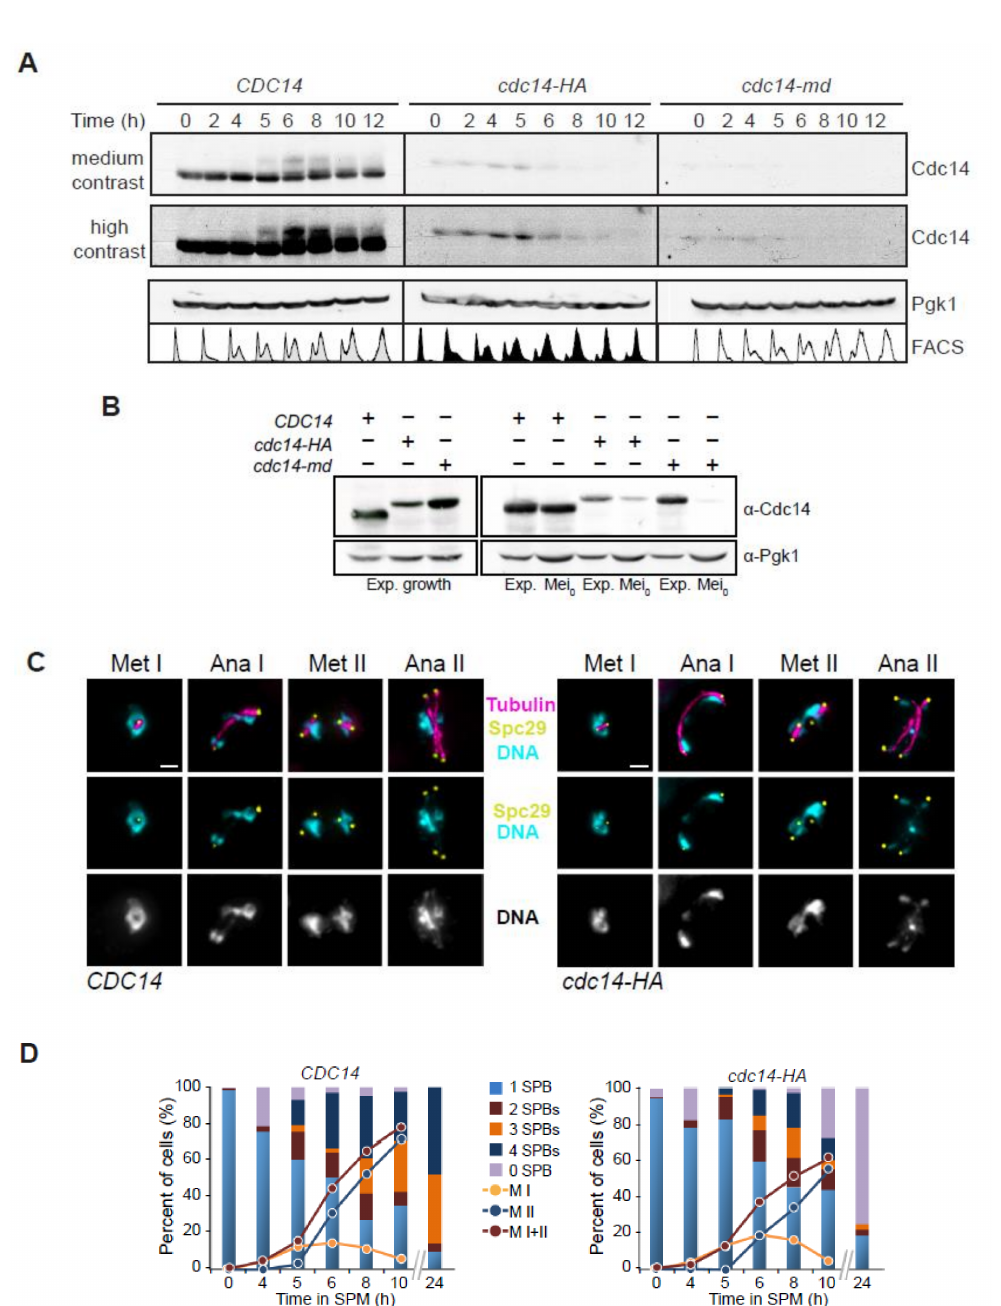
Figure 2. Diminished Cdc14 protein levels in cdc14-HA meiotic cells compromise SPB integrity following meiotic divisions. ( A ) Dynamics of Cdc14 protein levels throughout meiosis in synchronous time courses for CDC14 (JCY2232), cdc14-HA (JCY2231), and cdc14-md (JCY2389). Higher contrast was applied to visualize residual protein levels for all three strains. Immunodetection of Pgk1 was used as a loading control. FACS histograms for each time-point are depicted at the bottom to show the degree of synchrony reached in each culture. ( B ) Variability of protein levels in mitotic versus meiotic cells in different CDC14 alleles. Exponentially growing cells show similar Cdc14 levels, excluding cdc14-HA , which has lower overall protein levels (left panel). Direct comparison between the three alleles CDC14 (JCY2232); cdc14-HA (JCY2231) and cdc14-md (JCY2389) in exponentially growing mitotic cells (Exp.) and meiotic cultures immediately after they were transferred to SPM (Mei 0 ). The loading control for each lane was determined using Pgk1. ( C ) Visualization of Spc29-CFP at SPBs, tubulin, and DNA, in wild-type (JCY892) and cdc14-HA (JCY893) cells fixed at different stages of meiosis at 30 ◦ C. Scale bar represents 1 µ m. ( D ) cdc14-HA cells develop meiosis I and II spindles with near wild-type kinetics. Lack of spore formation in cdc14-HA meiotic cells parallels the loss of SPB’s structural